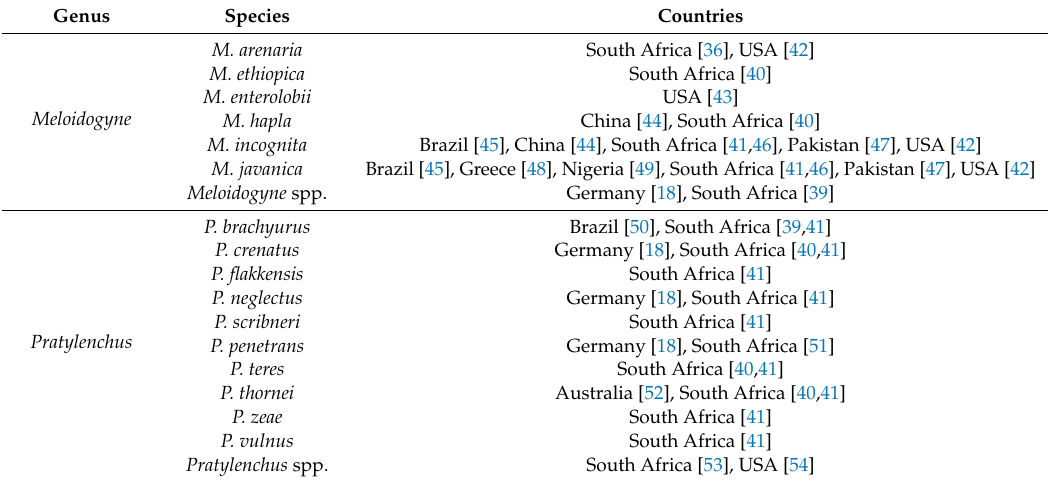
Table 2. Countries where Meloidogyne and Pratylenchus spp. have been found to be associated with